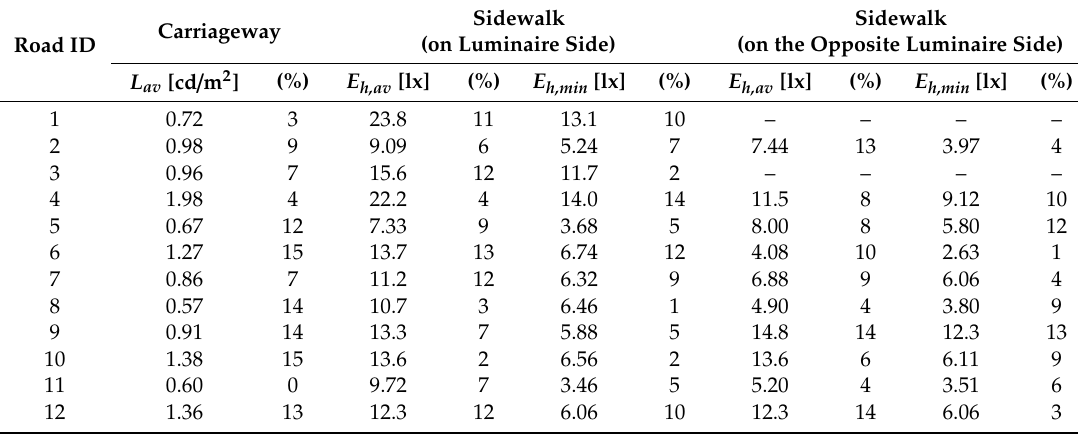
Figure 10. False-colour renderings of the horizontal illuminance mapping for some analysed roads at the present status (one for each group of Table 1). Table 8. Results of the software simulation at the present status for the considered lighting parameters. For each parameter the percentage deviations between measured (see Table 7) and simulated values are also indicated. The luminance and illuminance values are expressed with three